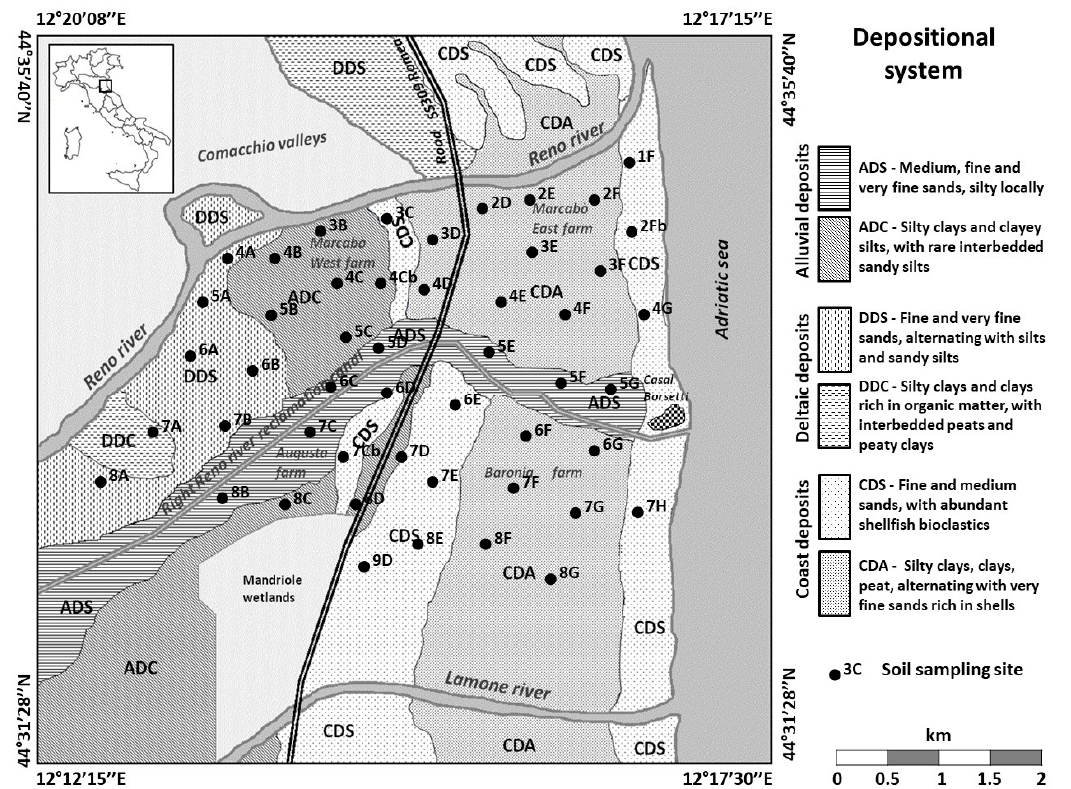
Figure 1. Depositional system of the study area according to ISPRA [19].